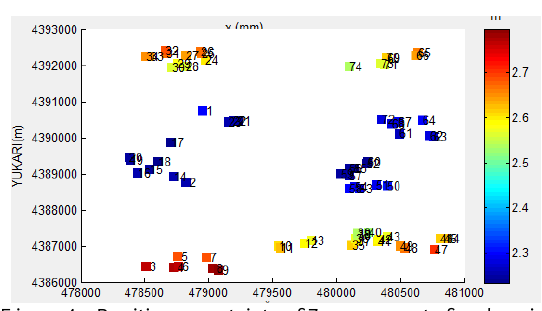
Figure 3.b Distribution of uncertainty for Y component for